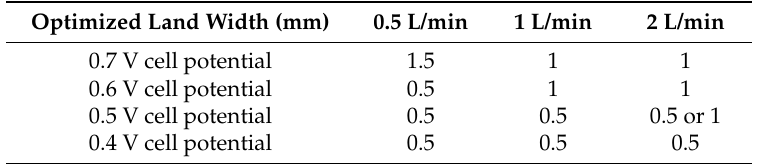
Figure 6. Comparison of net power densities that include the pumping power at different land widths: ( a ) Inlet flow rate = 0.5 L/min; ( b ) inlet flow rate = 1 L/min; ( c ) inlet flow rate = 2 L/min. Table 3. Optimal land width in single serpentine flow fields at different inlet flow rates and different cell potentials when the pumping power is considered.